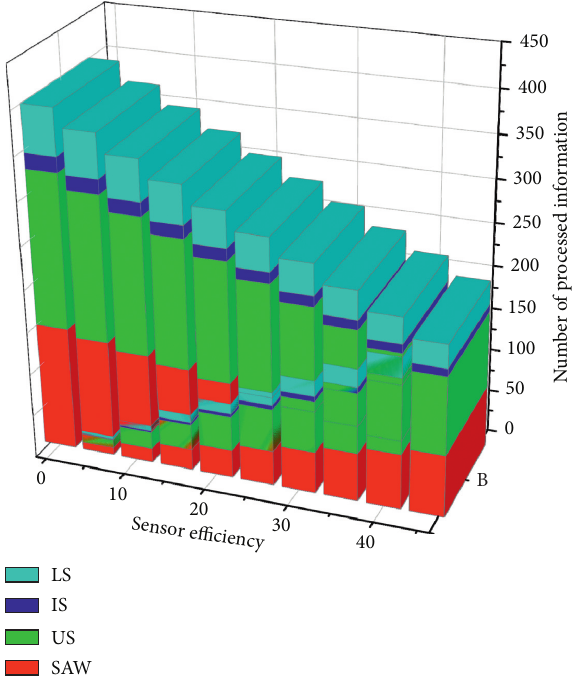
Figure 7: Comparison of efficiency after applying SAW wireless